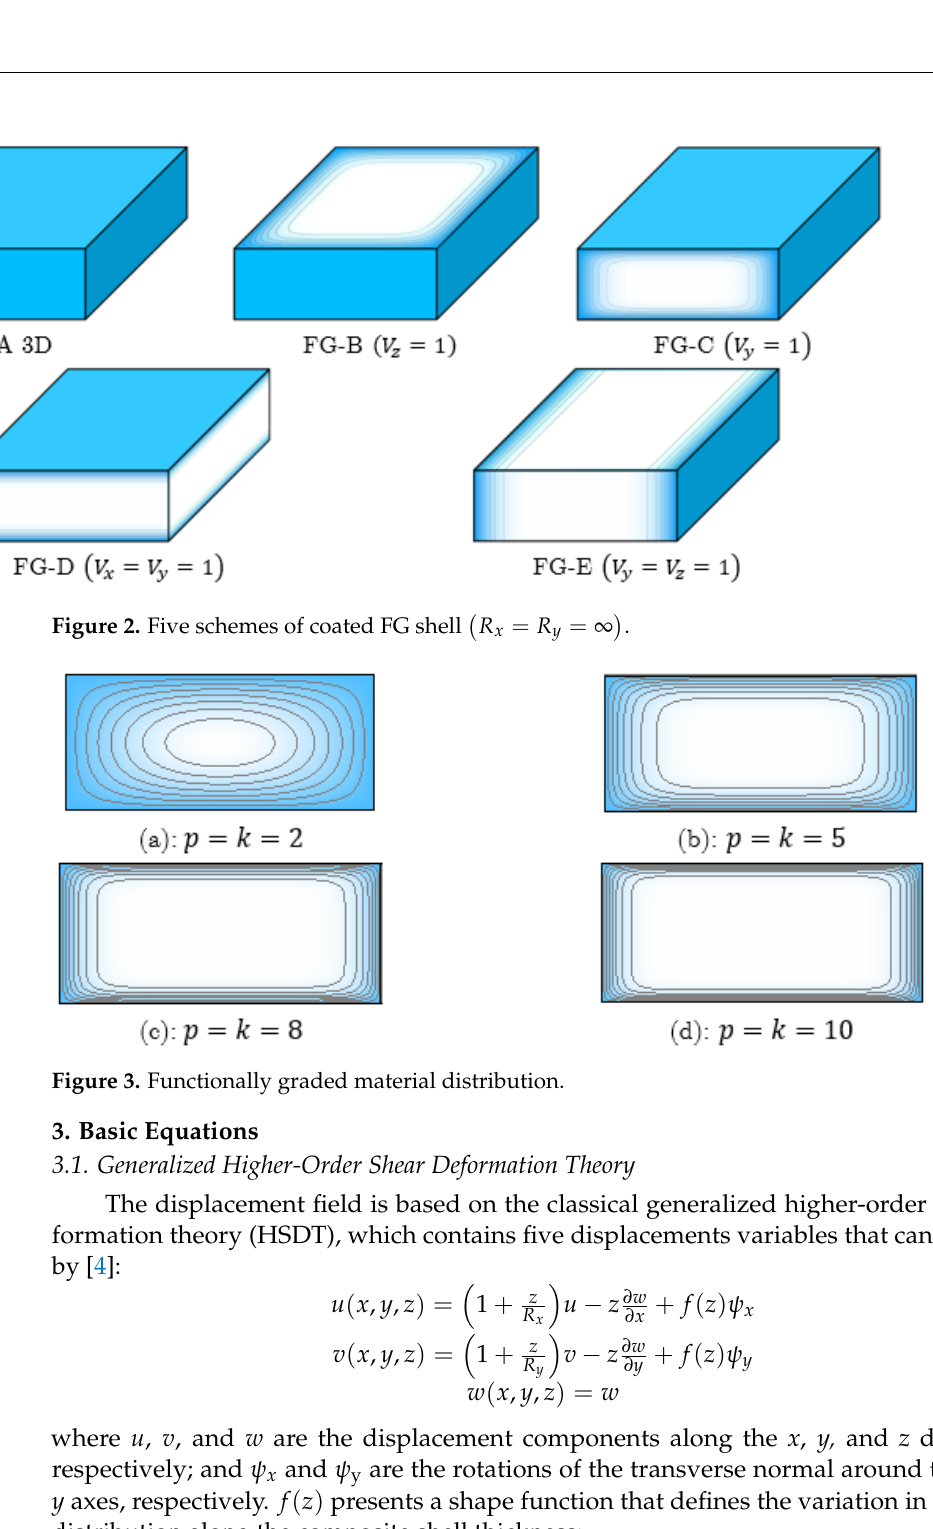
Figure 1. FG spherical shell geometry.